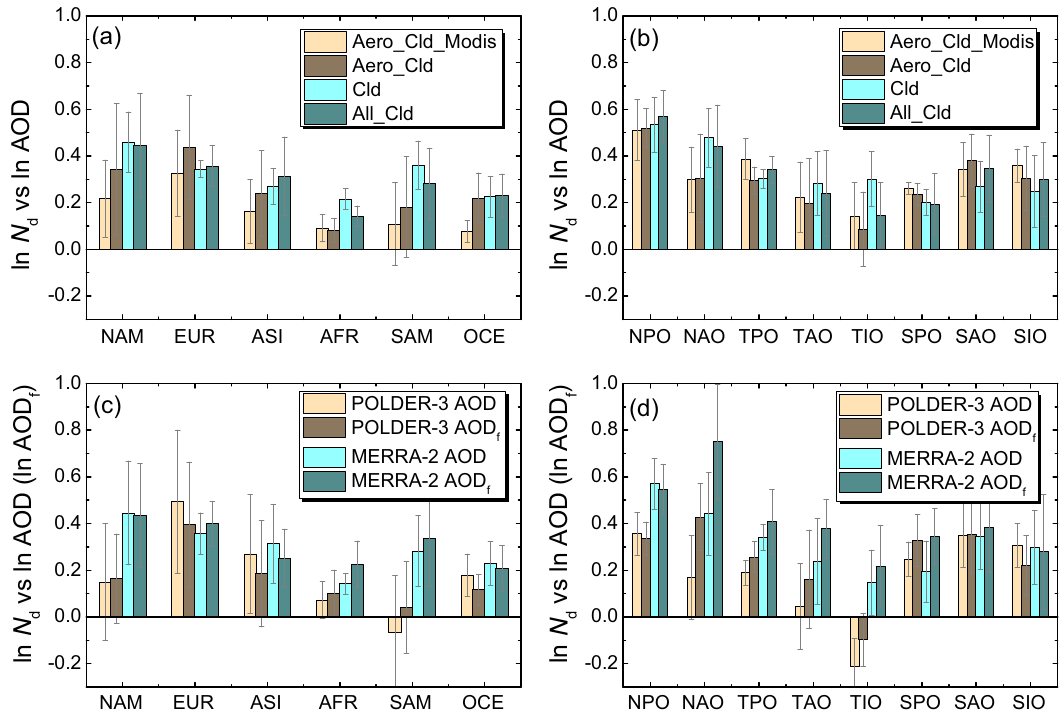
Fig. 3 Annual averaged slopes of the linear regressions between the logarithm of cloud droplet number concentration ( N d ) and those of aerosol optical depth (AOD) and fi ne-mode AOD, i.e., ln N d versus ln AOD (AOD f ), for different scenarios. a , b The slopes calculated from retrieved AOD- N d data pairs (Aero_Cld_Modis), and from MERRA-2 re-analyzed AOD and CERES-retrieved N d data pairs for the scenario that aerosol and cloud retrievals are simultaneously successful (Aero_Cld), the scenario that only cloud retrievals are successful (Cld), and the scenario including all ambient clouds (All_Cld). The slopes calculated by POLDER-3 AOD, POLDER-3 fi ne-mode AOD (AOD f ), MERRA-2 AOD (same as All_Cld), and MERRA-2 AOD f are also shown ( c , d ). The annual averaged slope here is the average of the monthly slopes. The standard deviation of the inter-monthly variability of the regression slopes is shown as an error bar. A total of 12 × 14 × 7 = 1176 linear regressions (for twelve months, fourteen regions and seven scenarios) were conducted, among which the slopes for 95% cases are at a statistically signi fi cant level (according to a Student ’ s t test, α =